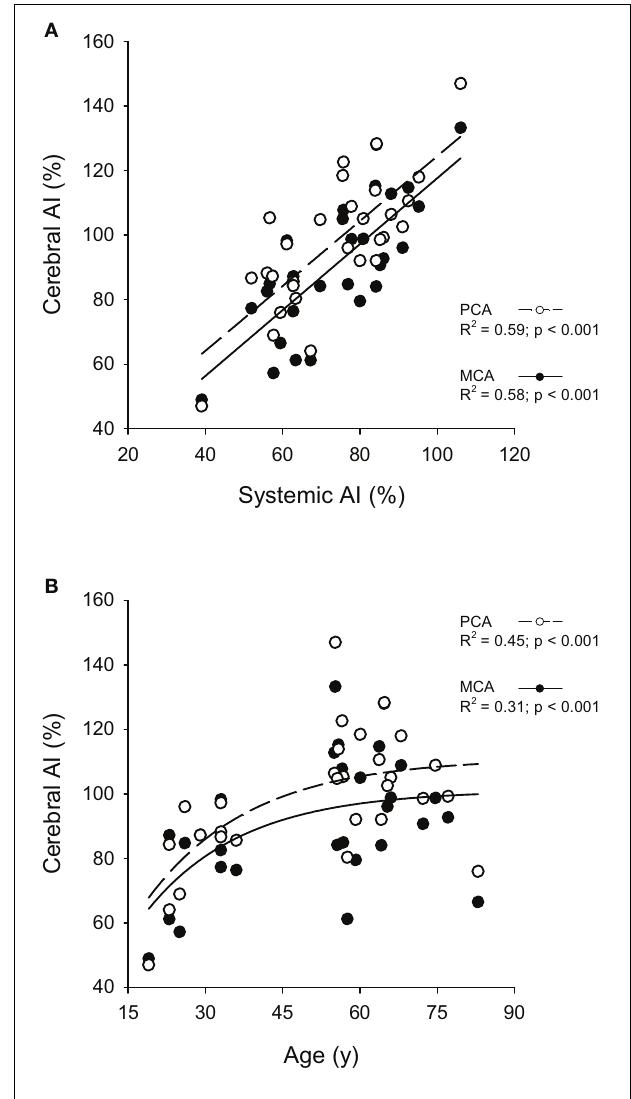
FIGURE 5 | Relationships between the cerebral augmentation index (Cerebral AI) and Systemic AI in the middle (MCA) and posterior cerebral arteries (PCA) (A) and Cerebral AI and Age in MCA and PCA